Question: Which visualization type does this figure use?
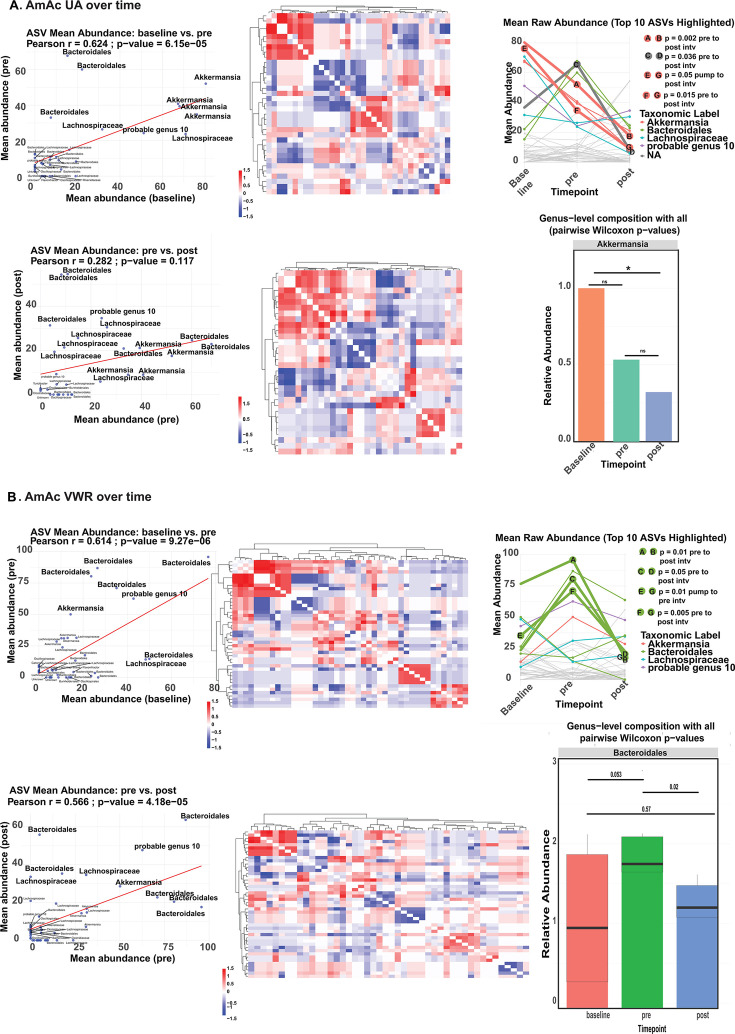
Answer: scatter